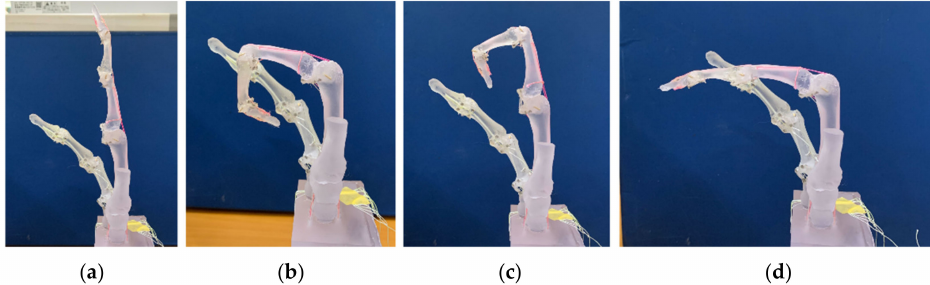
Figure 8. Index finger operation with multiple muscles. ( a ) neutral position; ( b ) flexion of index